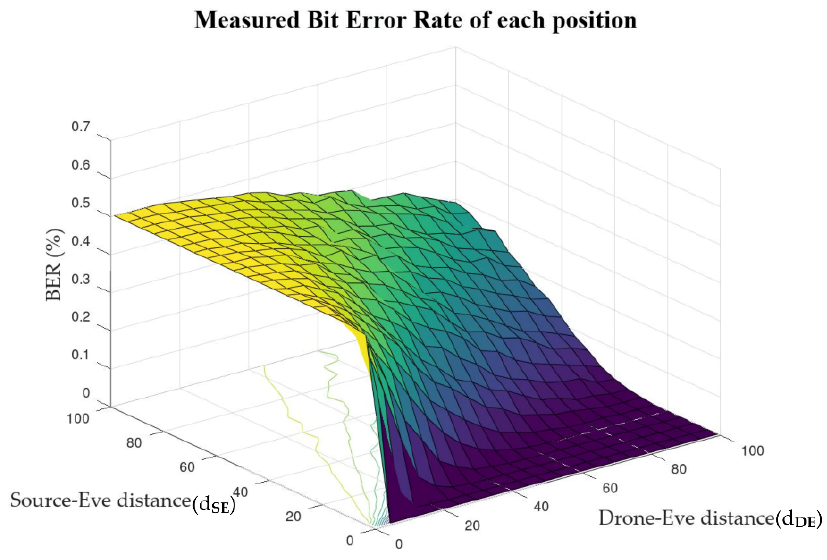
Figure 3. BER based on distance of Source-Eve and